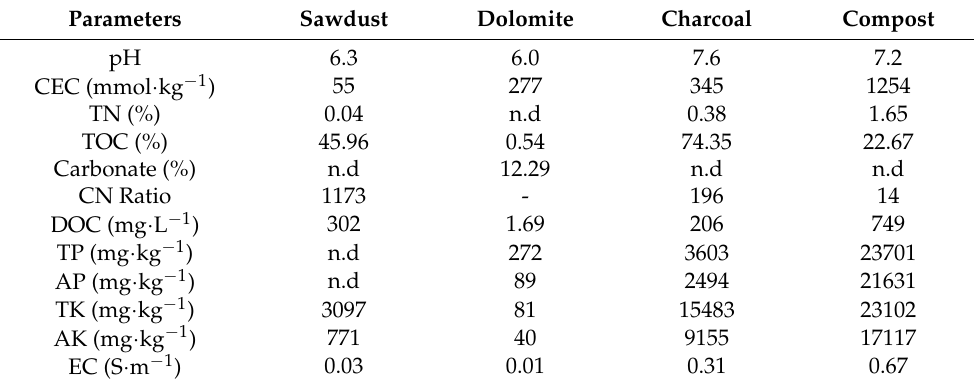
Table 3. Physicochemical properties of the soil amendments used in the experimental site. Cation exchange capacity, CEC; total nitrogen, TN; total organic carbon, TOC; dissolved organic carbon, DOC; total phosphate, TP; available phosphate, AP; total potassium, TK; available potassium, AK; and electrical conductivity, EC. Given are mean ( n = 2). Parameters Sawdust Dolomite Charcoal Compost